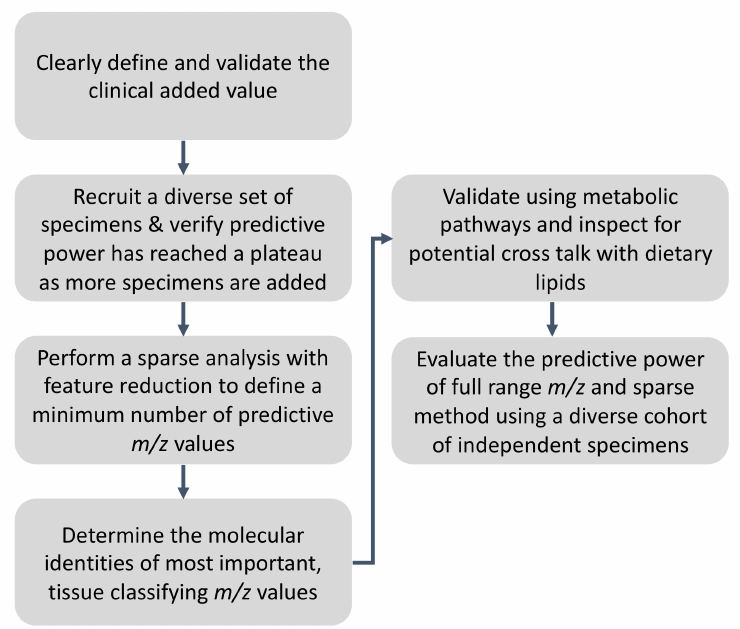
Figure 4. Recommendations for ambient MS profiling workflow focused on utility for rapid pathology determination. Summarizing the material gathered and discussed in this review and major sources